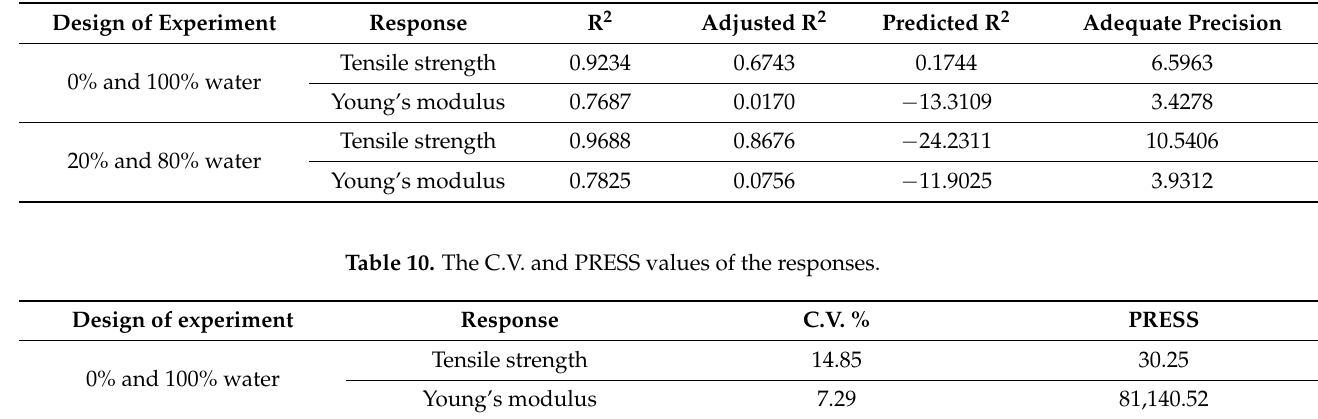
Table 9. The fit statistics of the experimental responses.